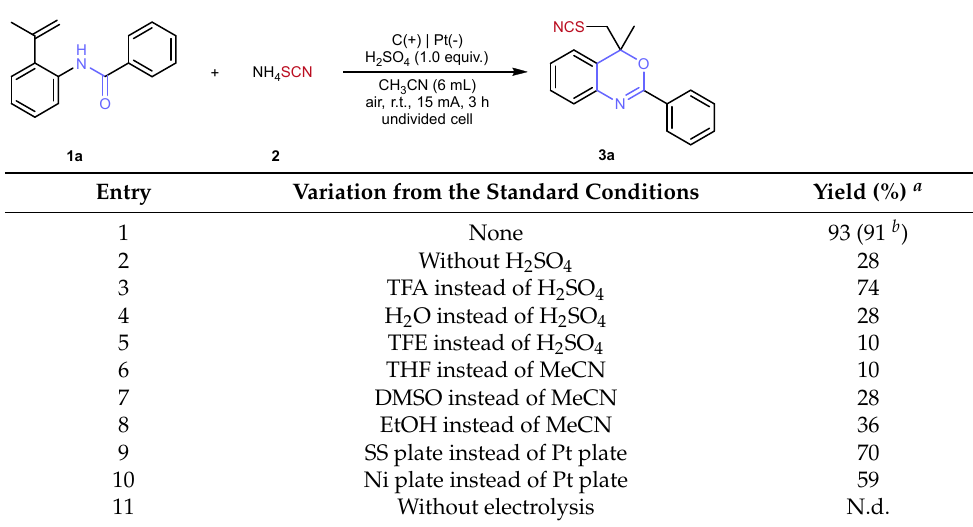
Table 1. Condition Table 1. Condition optimization.